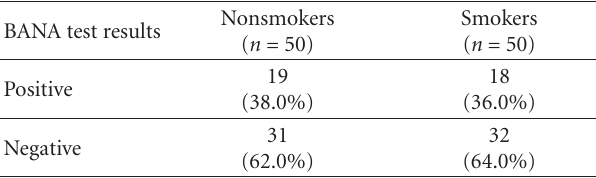
Table 9: Comparison of BANA test positive between nonsmokers and smokers.